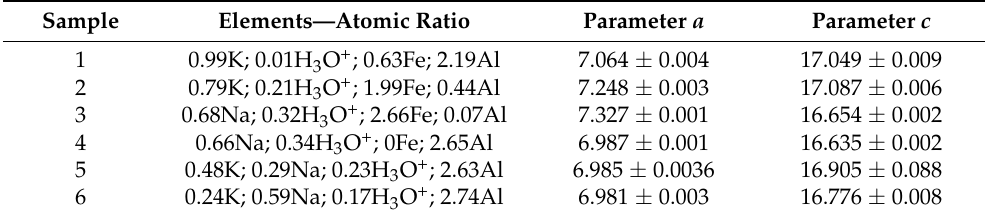
Table 4. Unit cell parameters of several samples of jarosite-alunite